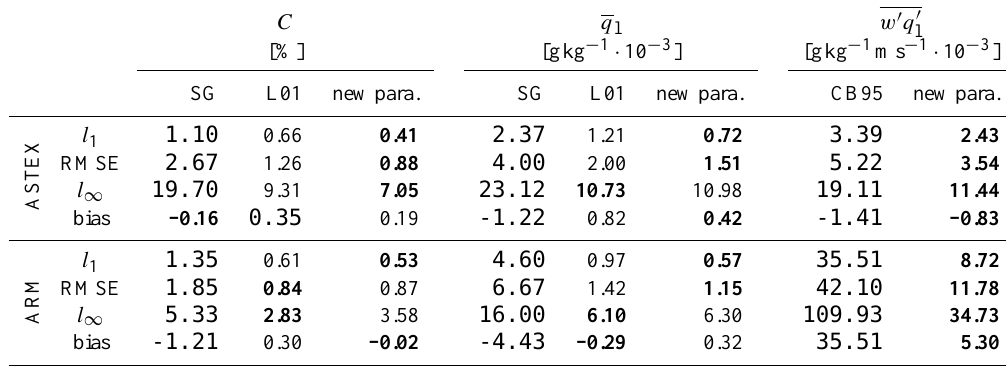
Table 2. Errors of the different parameterizations for the testing data sets, ASTEX and ARM.